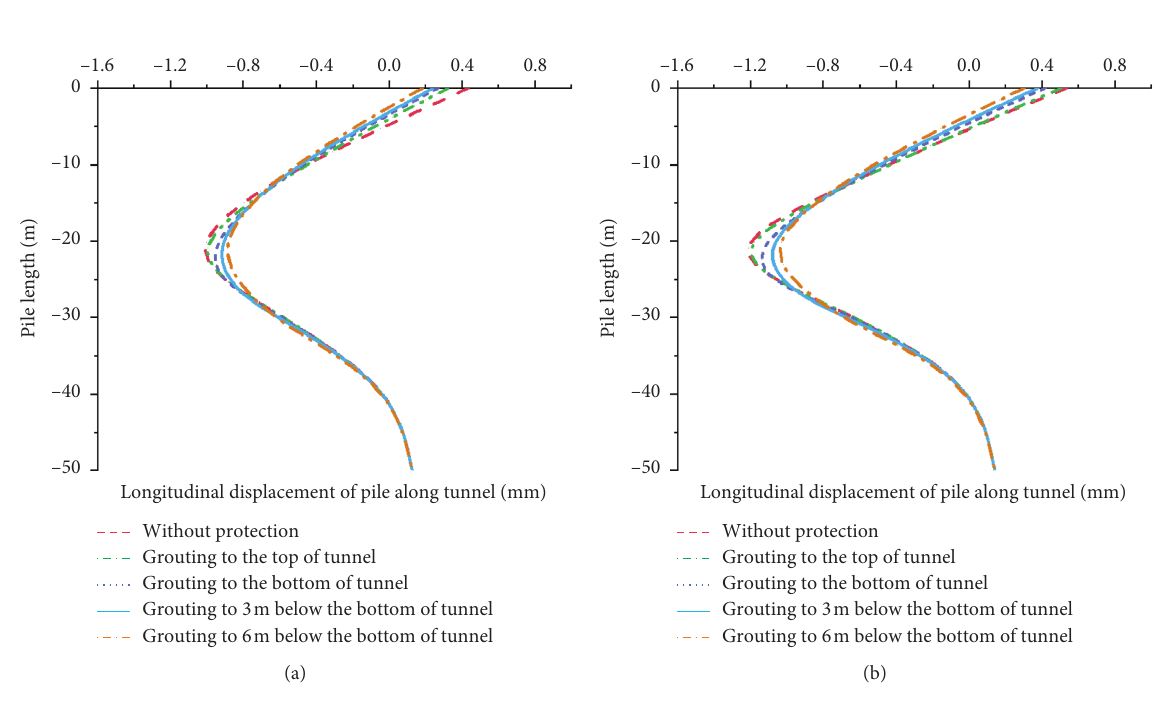
Figure 14: Longitudinal displacement of the pile along the tunnel: (a) 10 rings before arriving at the pile; (b) 8 rings before arriving at the pile.